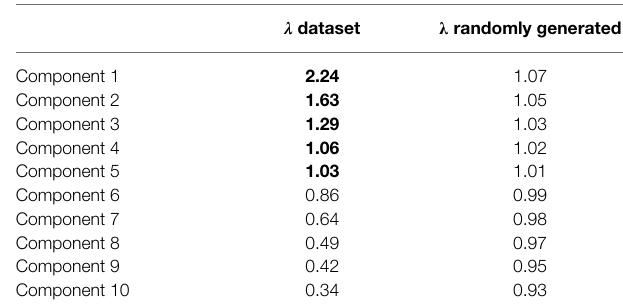
TABLE 8 | Parallel analysis for the N-TIPI component